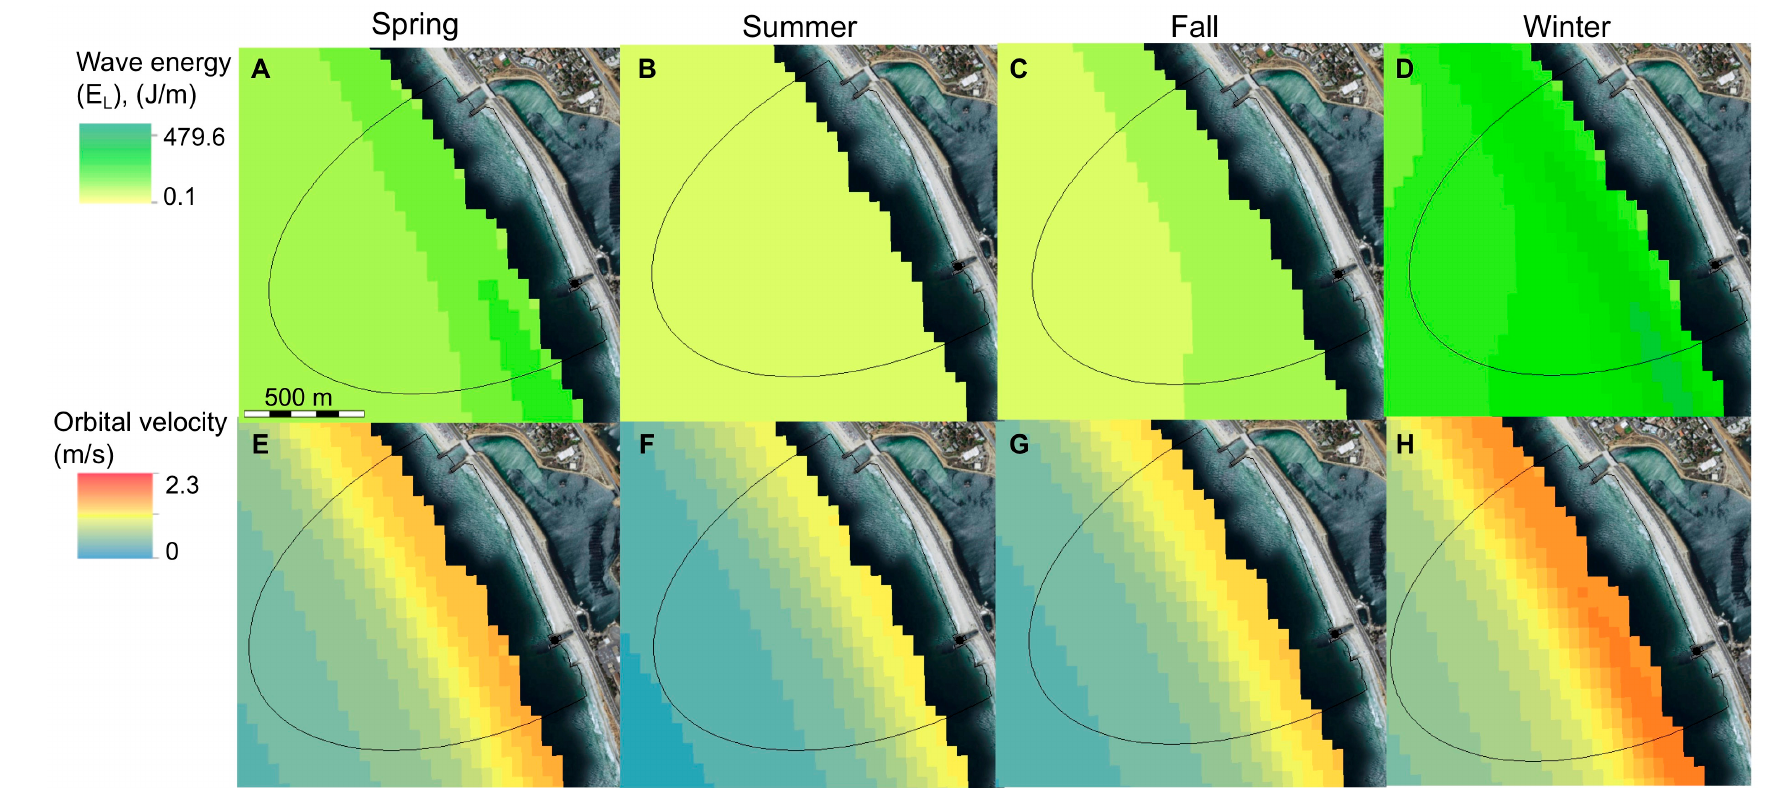
Figure 4. GIS-mapped averaged seasonal wave energy density (upper row A – D ) and orbital velocity (lower row E – H ) during spring, summer, fall and winter. The black parabola indicates the extent of the area of our field samples.